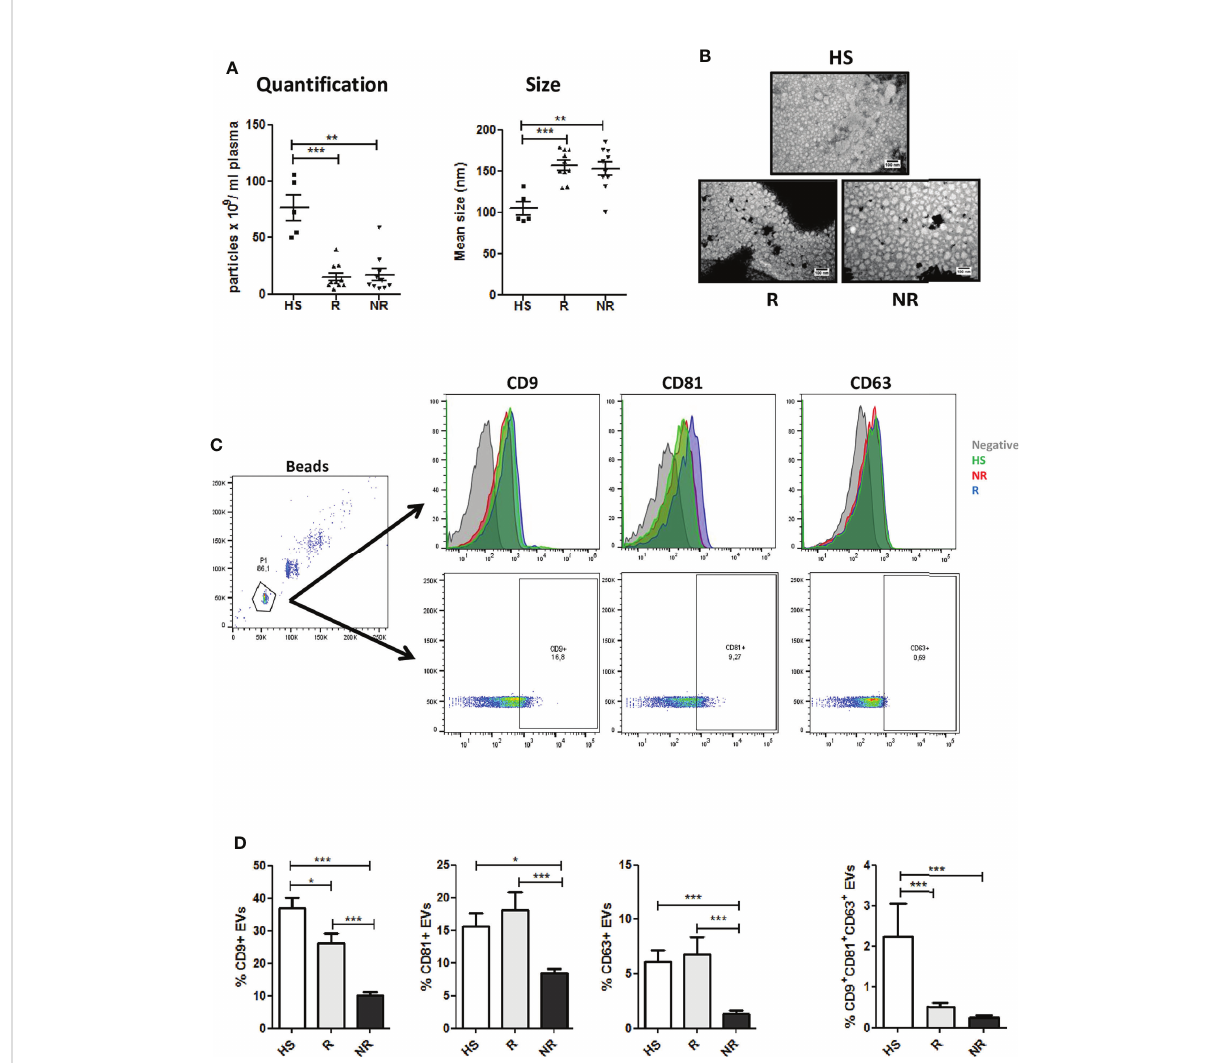
FIGURE 1 Characterization of plasma EVs from NSCLC patients at baseline. (A) Concentration and size distribution of EVs from Responder (R) compared to EVs from Non Responder (NR) patients and heavy smokers (HS) healthy controls, using nanoparticle tracking analysis (n = 10 per group). (B) Representative TEM images showing the spherical morphology and size distribution of plasma-derived EVs. (C) Flow cytometric analysis of conventional EV markers (CD63, CD81, CD9) on HS, R and NR-EVs. Representative histogram and dot plots are reported . (D) Histogram show the percentages of CD63, CD81, and CD9 positive EVs, or the percentage of CD9/CD81/CD63 triple positive EVs in the three cohorts (HS n = 5; R n = 13; NR n = 48). Data are expressed as mean value ± S.E.M. values. (*p < 0.05; **0.05 < p < 0.001; ***0.001 < p <